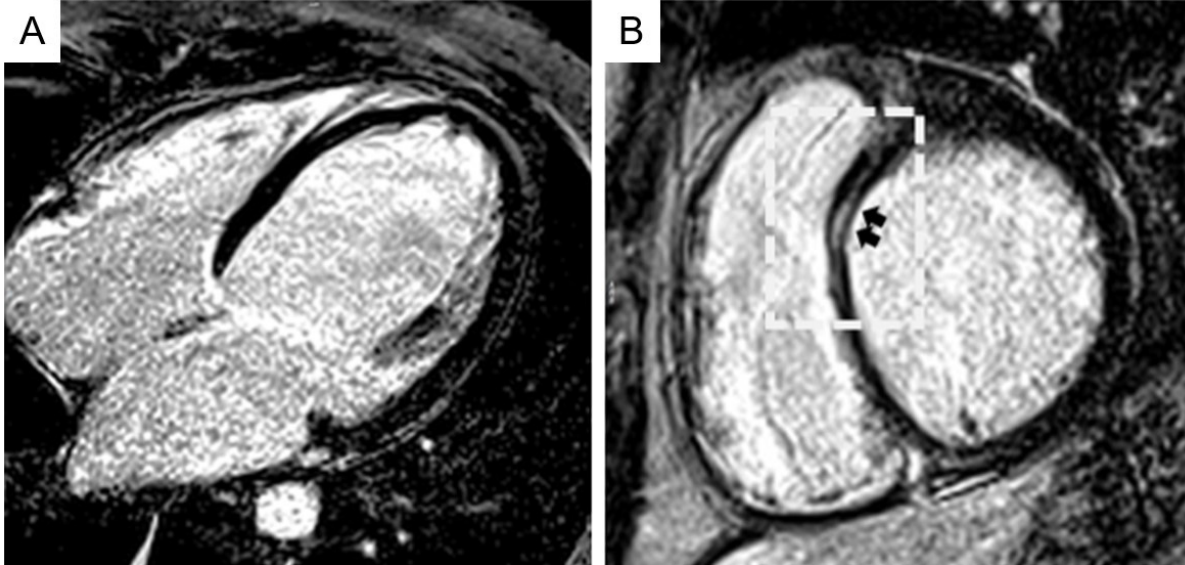
Figure 5. Cardiac magnetic resonance (CMR) imaging features of a patient affected by dilated cardiomyopathy. Post- contrast long-axis ( A ) and short-axis ( B ) CMR views evidencing a severely dilated left ventricle cavity and myocardial late gadolinium enhancement (black arrows), limited to the anteroseptal region (boxed area). Modified from ref [70].